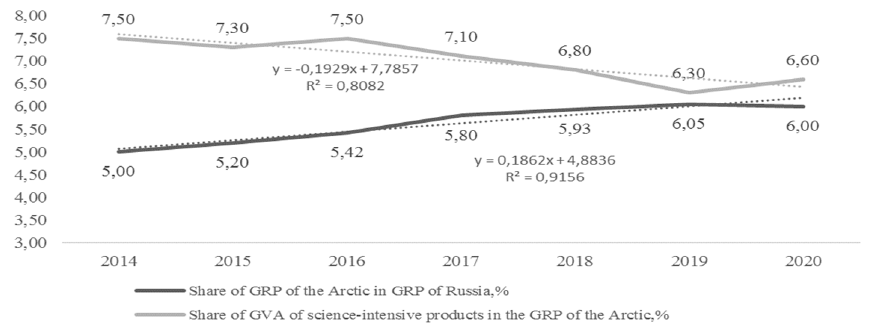
Figure 1. The dynamics of gross value added (GVA) of the science-intensive industry and the gross regional product (GRP) of the Arctic zone (compiled by the authors).